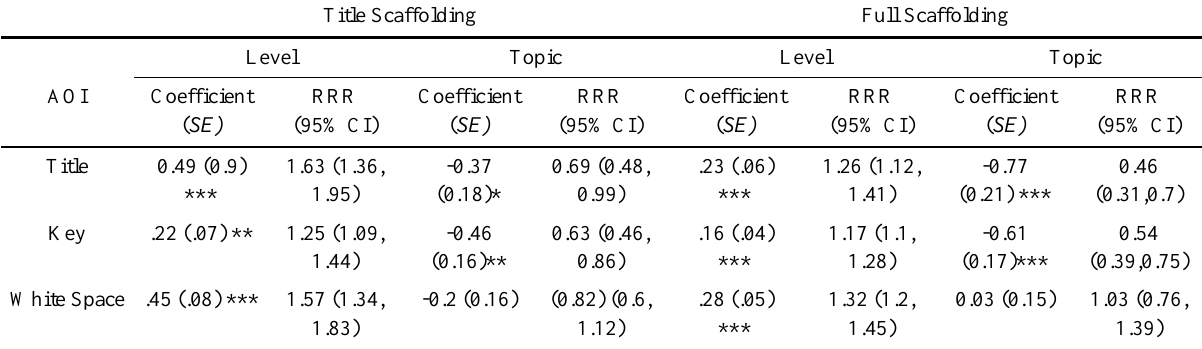
Relative Risk Ratios for Areas of Interest, Unscaffolded versus Title and Full Scaffolding, All Subjects (n = 16), SL.